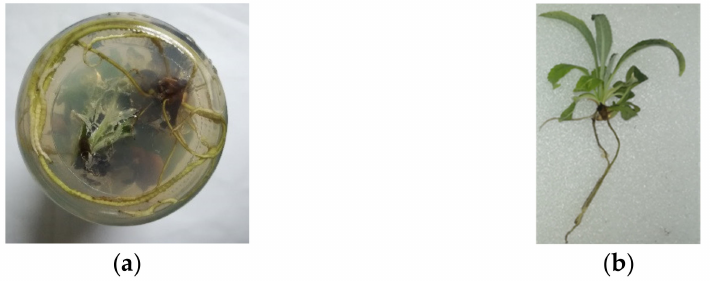
Figure 3. ( a ) In vitro roots of artichoke after 5 weeks; ( b ) plant ready for acclimatization in a